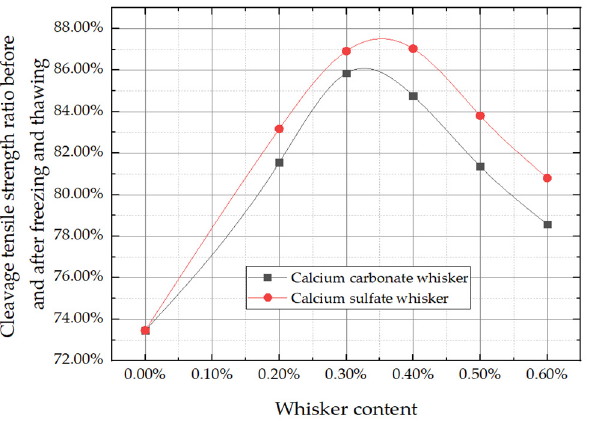
Figure 9. Splitting tensile strength ratio before and after freezing and thawing.